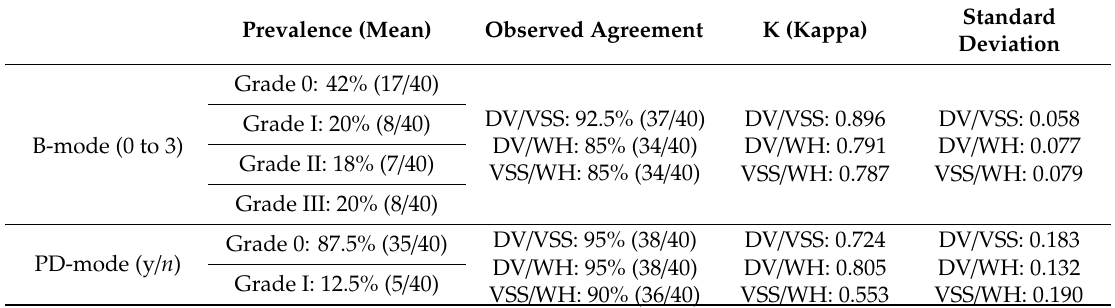
Table 3. Inter-reader reliability and assessment in 40 patients with rheumatoid arthritis .